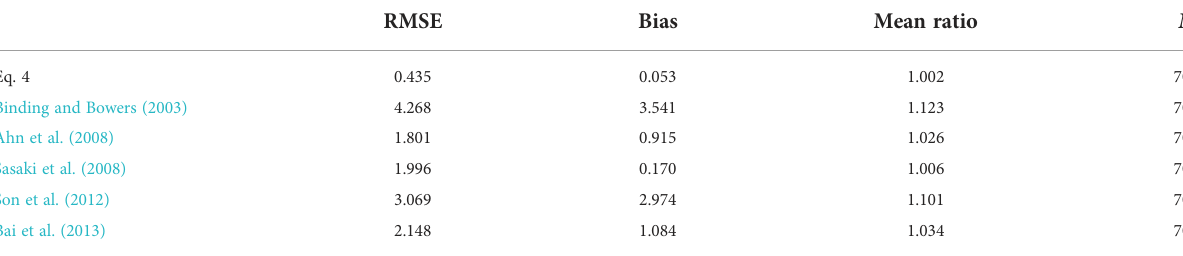
RMSE, bias, and mean ratio values are calculated using matched and validation